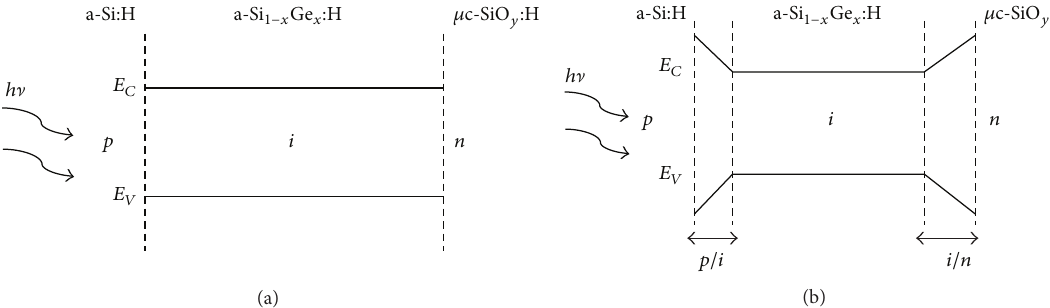
Figure 2: The schematic band structure of a-Si 1− both the p/i and the i/n interfaces.